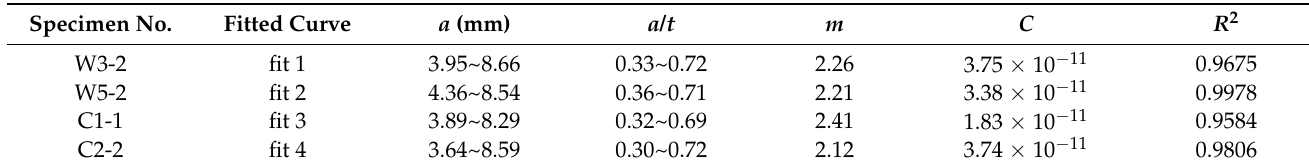
Table 8. Summary of fitted curves (d a /d N : m/cycle; ∆ K : MPa · m 1/2 ). Specimen No.